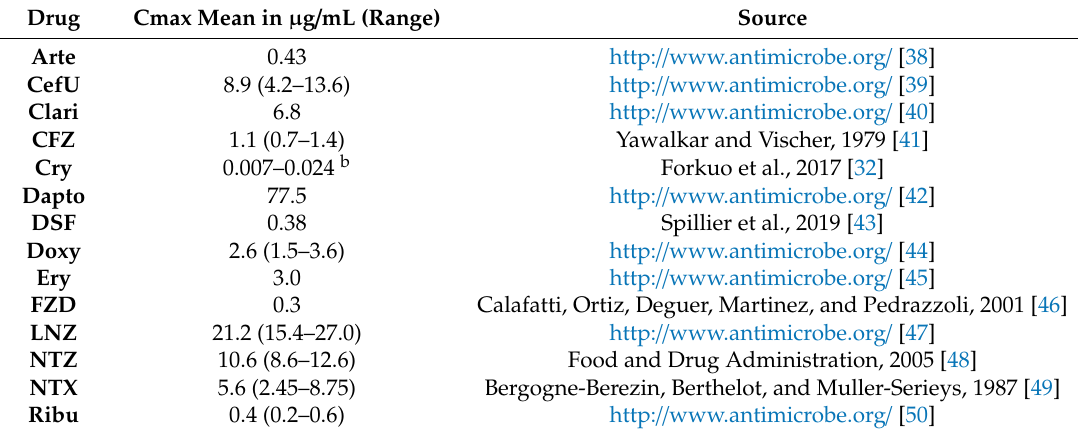
Table 5. Cmax concentrations for drug candidates. Cmax values presented in the table are for oral drugs, except for daptomycin, which is an intravenous antibiotic. When needed, Cmax was converted from a molar to a µ g / mL concentration. For the purpose of this study, drugs were tested at their mean concentration value (range) a